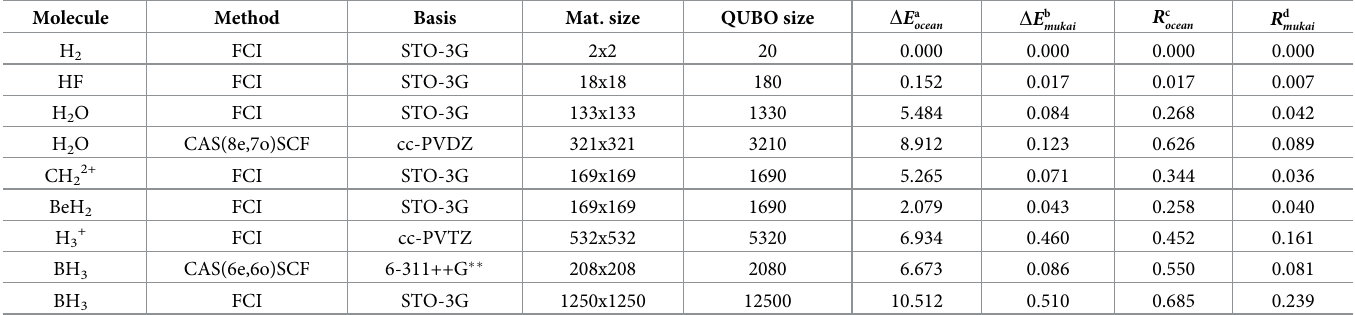
Table 1. Electronic ground state energy errors in kcal/mol.